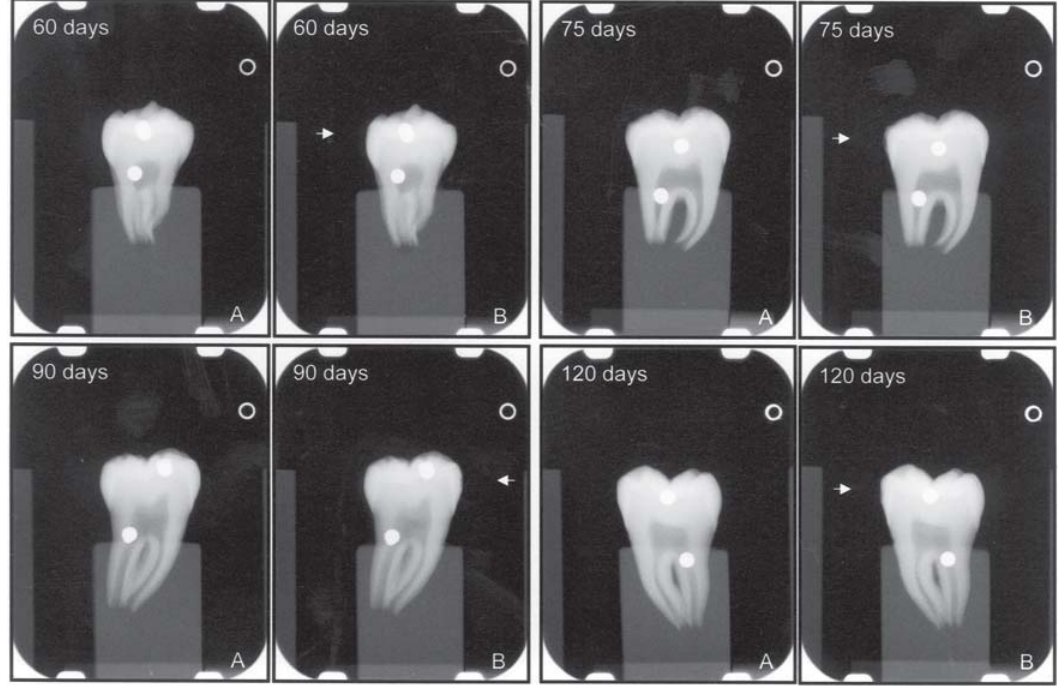
FIGURE 2- Radiographic images of experimental specimens, before (A) and after (B) the demineralization periods. Arrow indicates the proximal surface presenting an artificial enamel subsurface